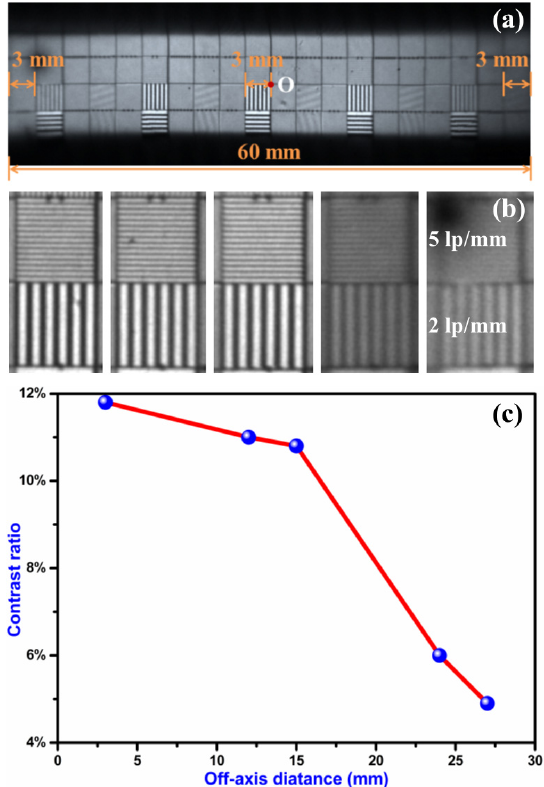
Figure 10. ( a ) The middle PC image with resolution mask. ( b ) The enlarged views of the mask with 2 lp/mm and 5 lp/mm in the middle PC image. ( c ) The relationship between the contrast ratio of 5 lp/mm mask and off-axis